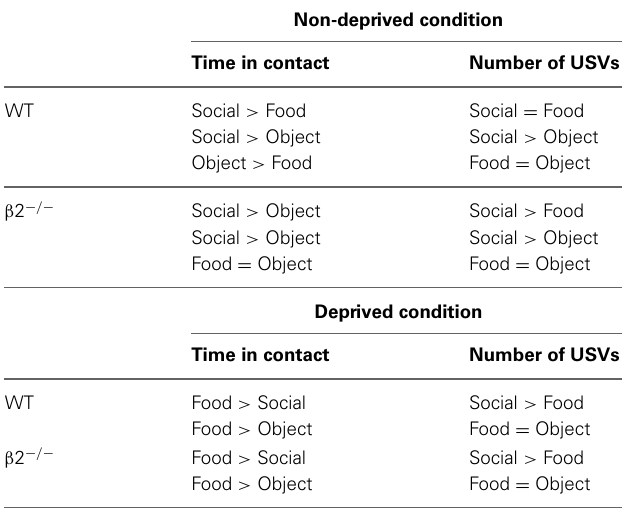
Table 1 | Summary of the reward ranking according to the two exposures of the three chambers tasks, before food deprivation and after food deprivation, for WT and β 2 − / −